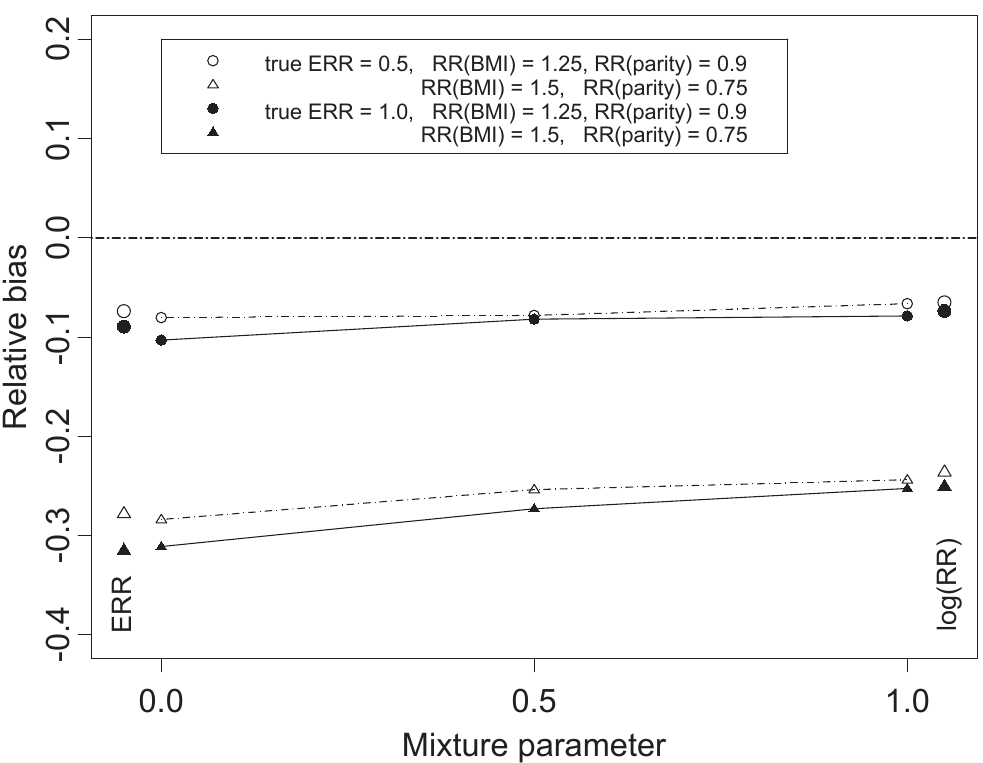
Figure 3. Simulated relative bias in the exposure risk estimate from the mixture model as a function of the mixture parameter. Based on cohort size N = 20,000, baseline prevalence p 0 = 0.05, and control:case ratio m = 2. Simulated relative biases for the excess relative risk (ERR) and logistic regression (logRR, where RR is relative risk) models are shown next to their equivalents in the mixture model for comparison. BMI, body mass